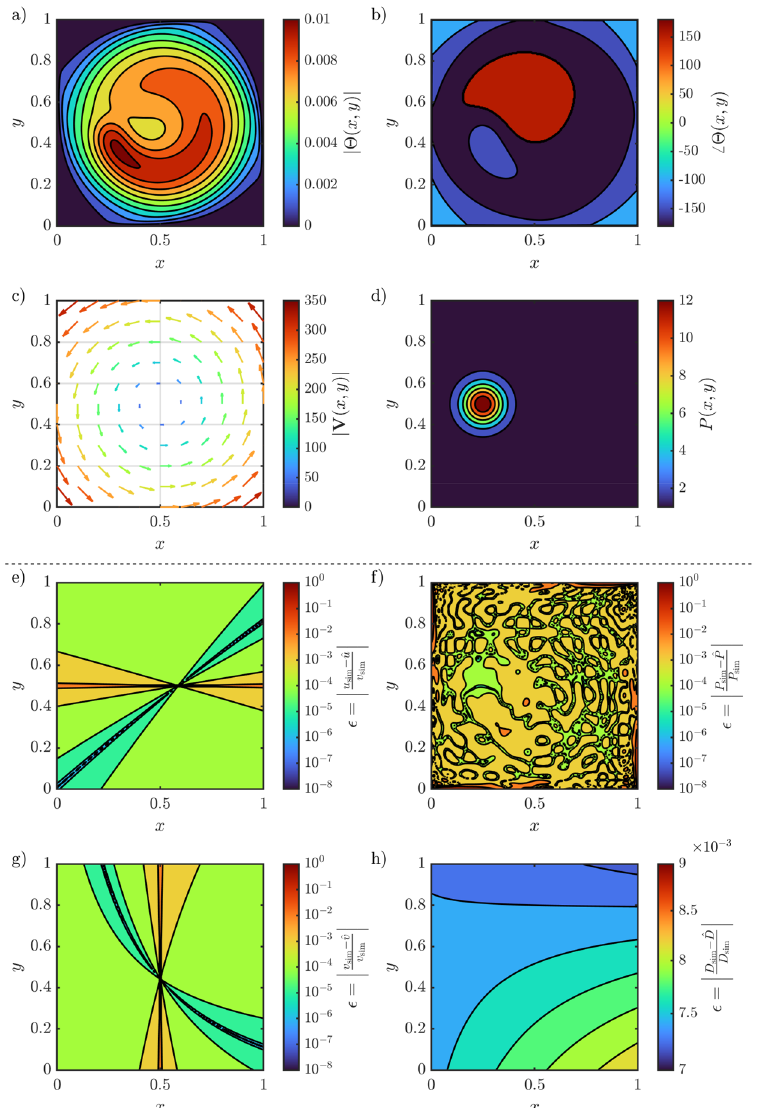
Figure 3. The 2D scenario with the absolute temperature profile of the modulation frequency at 25 Hz ( a ) and the phase ( b ), followed by the flow field ( c ) and source deposition profile ( d ). The relative estimation errors are shown for the x-component (e) and y-component ( g ) of the flow field, the source ( f ) and diffusivity ( h